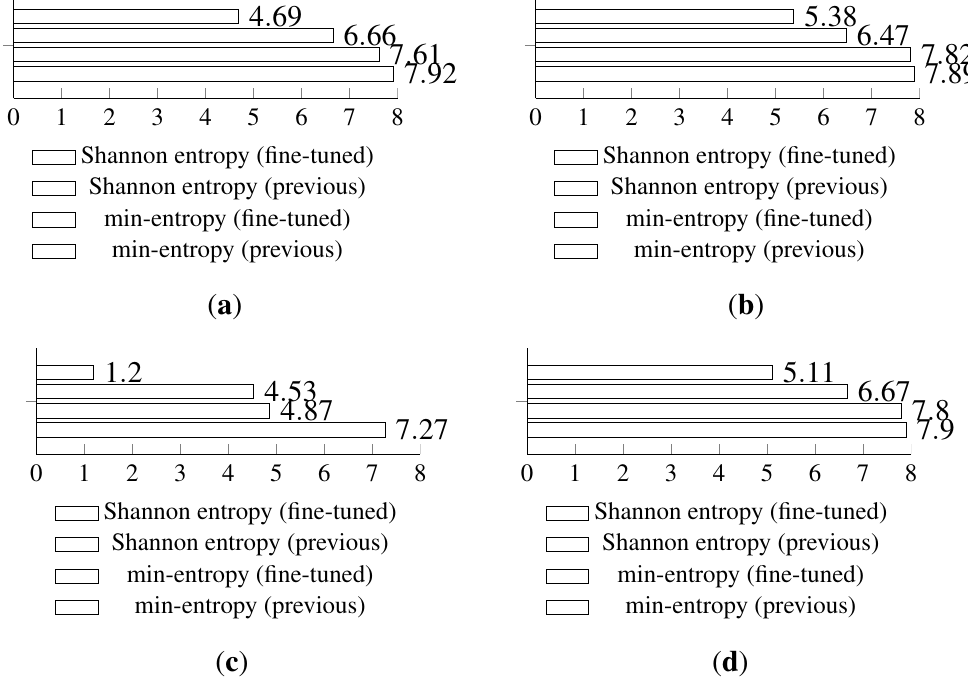
Figure 13. Shannon entropy and min-entropy estimations of previous (long-term results) and statistically fine-tuned versions of the entropy-harvesting method for the particular on-board sensors. ( a ) Light (1); ( b ) Light (2); ( c ) humidity; ( d )